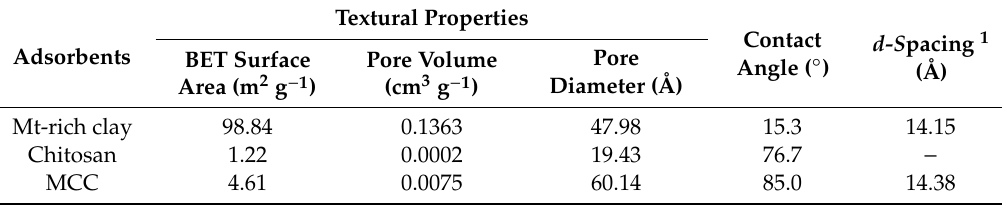
Table 1. Characterization of the adsorbents.